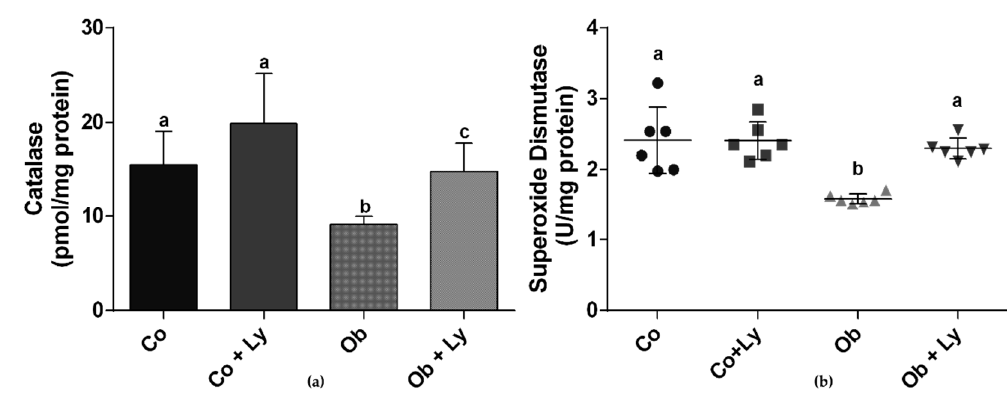
Figure 5. Antioxidant enzyme activity: ( a ) Catalase (pmol/mg protein); ( b ) Superoxide Dismutase (U/mg protein). Co: Control group; Co+Ly: Control group supplemented with lycopene; Ob: Obese group; Ob+Ly: Hypercaloric group supplemented with lycopene. Data parametric expressed in mean ± standard deviation. Comparison by two-way ANOVA with Holm-Sidak post-hoc test. Data non-parametric expressed in median and interquartile range. Comparison by Kruskall Wallis test with Tukey post-hoc test. Different letters correspond to the significant statistical difference ( p < 0.05); n = 6 animals/group.